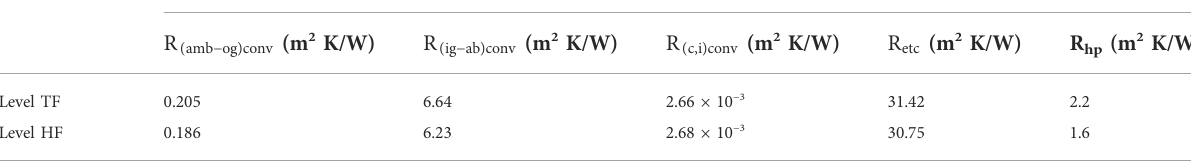
TABLE 5 Thermal resistance parameters of the evacuated glass tube and heat pipe. Experiments